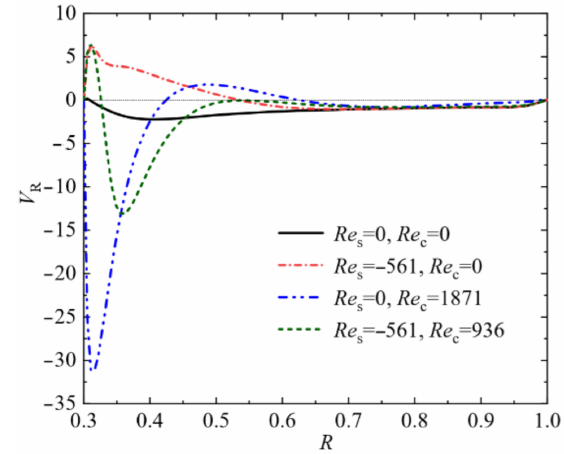
Figure 3. Distributions of surface radial velocity at Re T = 394.